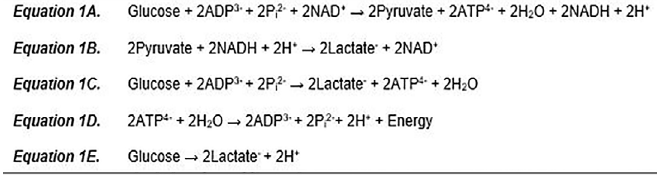
Figure. Anaerobic metabolism. A . Glycolysis; B . Reduction of pyruvate; C . Net glycolytic reaction under anaerobic